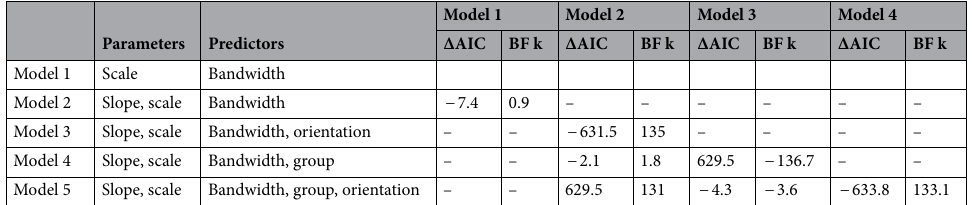
Table 2. Model comparison—orientation and bandwidth of spatial frequency information. Each cell describes model comparisons according to row and column. The BF k index is calculated as log10 BF, such that positive values of BF k reflect evidence in favor of the row model, and negative k values reflect evidence in favor of the column model. ΔAIC scores reflect changes in model parsimony (a function of the fit, given the number of parameters added in the row model relative to the column model). In general, negative values reflect more parsimonious fits for the row than column model and vice-versa.